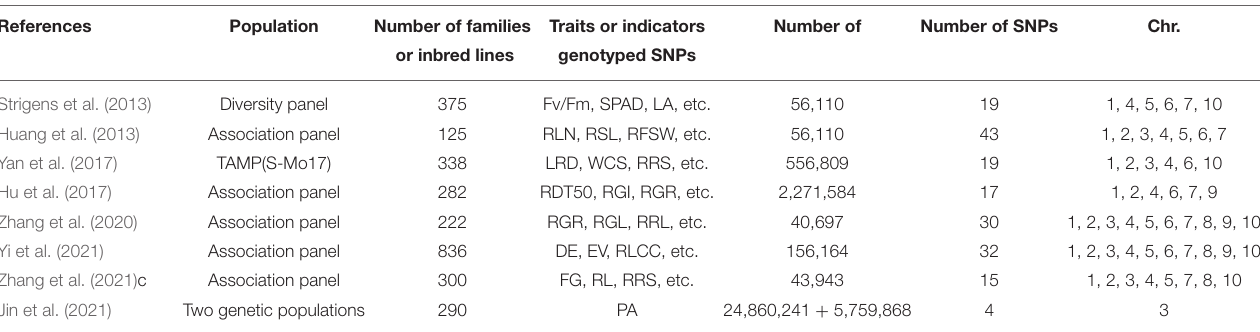
TABLE 2 | SNPs linked to traits related to the bud and seedling stages in